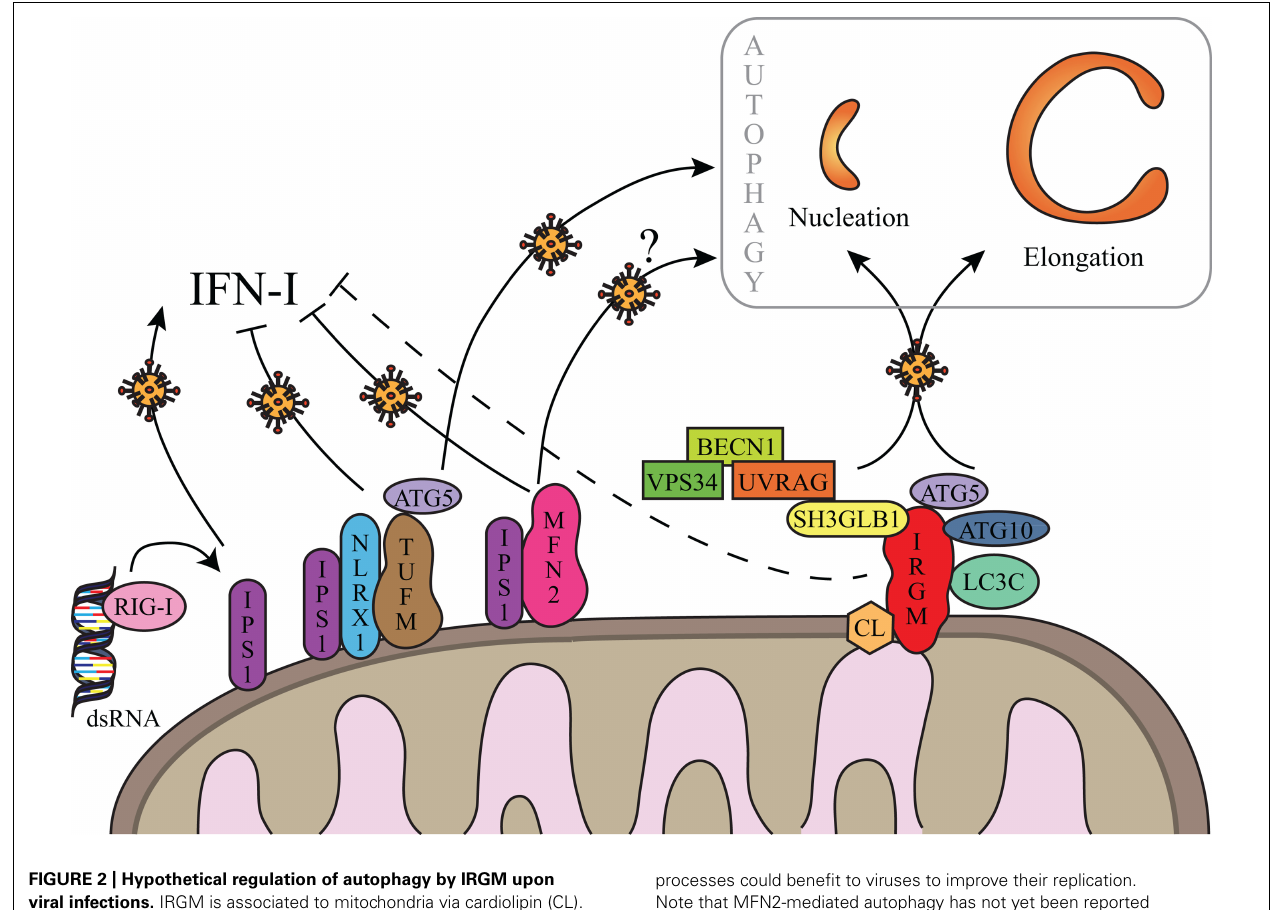
processes could benefit to viruses to improve their replication. Note that MFN2-mediated autophagy has not yet been reported in the context of viral infection (see text for details). As represented, viral double-stranded (ds)RNA can be recognized by RIG-I. IFN-I inhibition via IRGM is not yet demonstrated (dashed line) and putative not mitochondrial IRGM isoforms are not represented (see text for